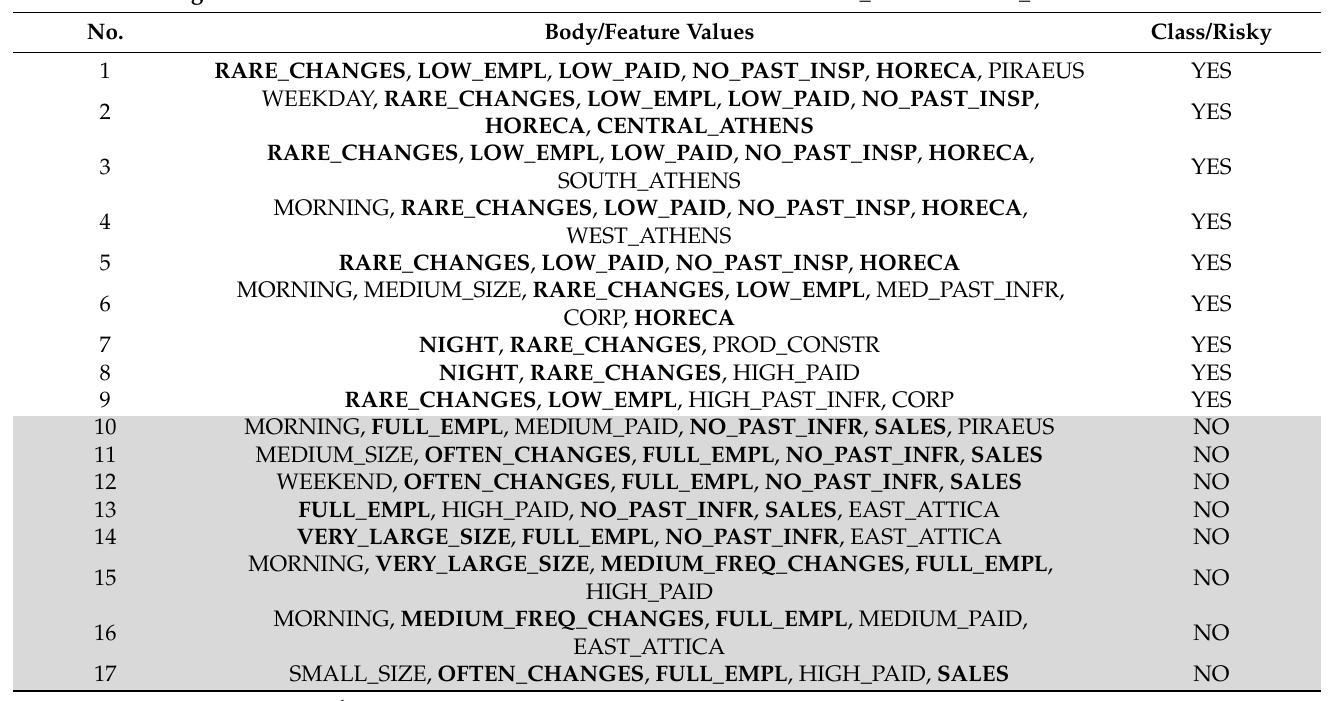
Table 15. Prevailing patterns of compliance and non-compliance as regards undeclared or underde- clared